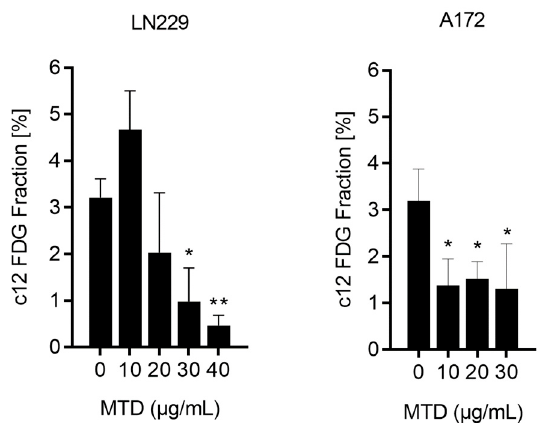
Figure 4. Level of cellular senescence in LN229 and A172 glioblastoma cells treated with MTD. Cells were harvested and measured 72 h after addition of MTD to the medium of exponentially growing cells. Data are the mean of three independent experiments. * p < 0.05; ** p < 0.01.